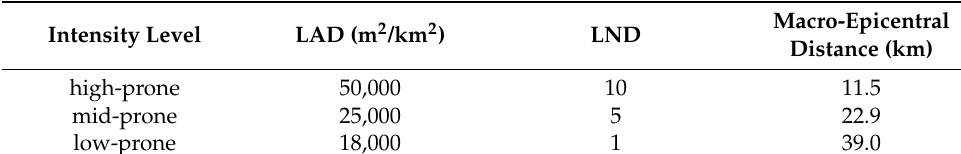
Table 2. Zoning value for landslide intensity.